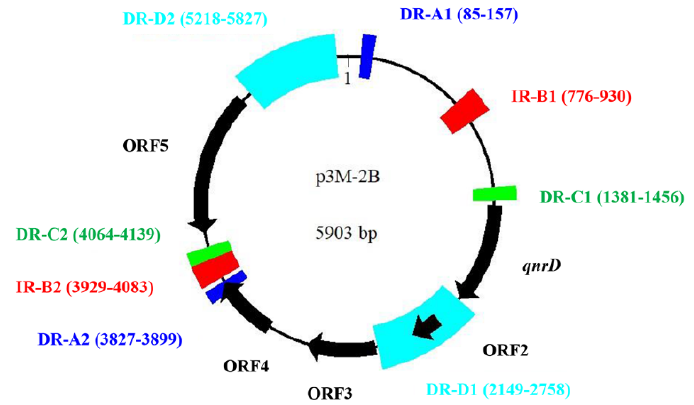
Figure 5. Graphical map of p3M-2B including direct repeats (DR) and inverted repeats (IR). Motifs of the same color represent a pair of DR or IR regions.